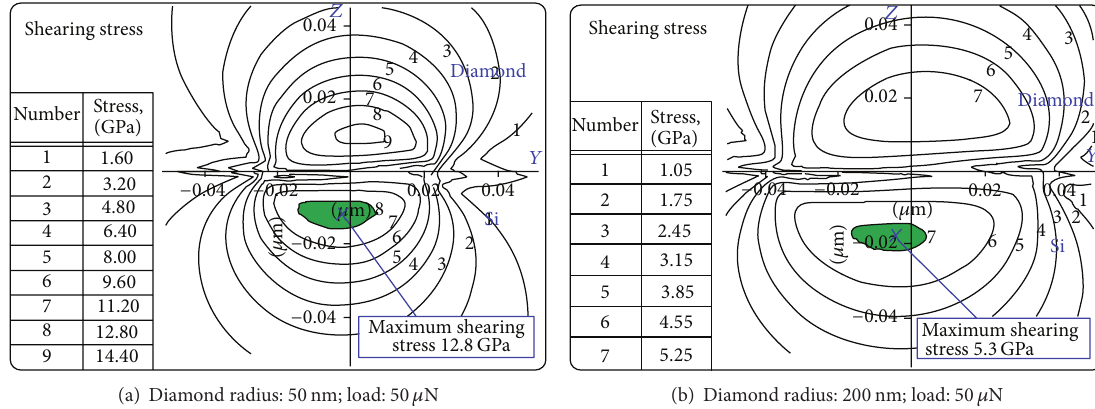
Figure 7: Shear stress of the silicon-diamond contact area at 50 𝜇 N load for tip radii of (a) 50 and (b) 200 nm.